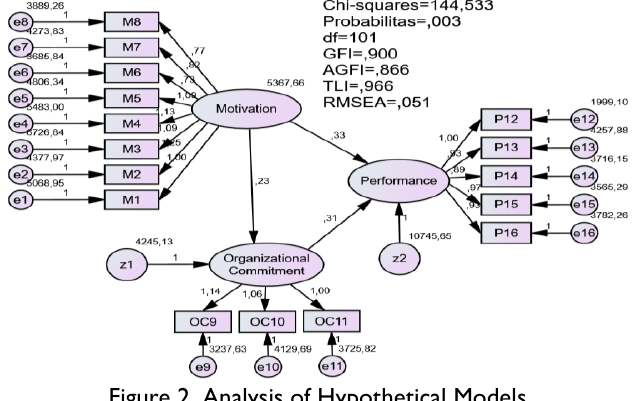
Figure 2. Analysis of Hypothetical Models